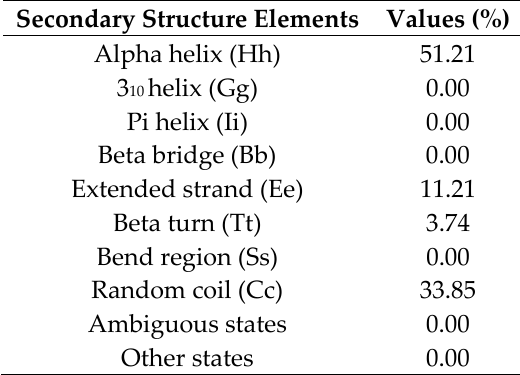
Table 2. Secondary structure